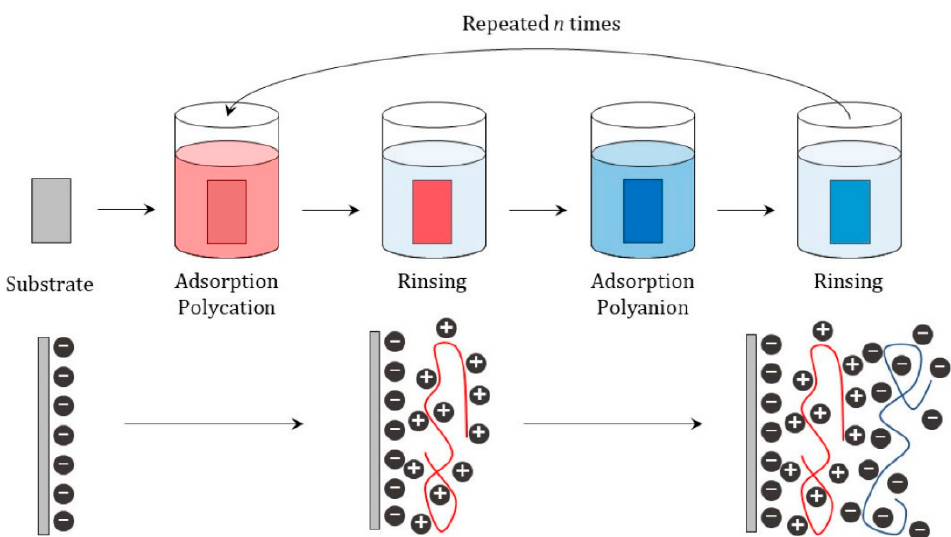
Figure 2. Sketch of the assembly of LbL nanomaterials by a dip-coating deposition methodology. The sketch represents the particular case of the assembly of a multilayer by the assembly of poly- electrolytes bearing opposite charges using a negatively charged flat substrate as template, and intermediate rinsing steps. In the bottom panel, the red line corresponds to the polycation layer evidenced by its positive charges, and the blue line corresponds to the polyanion layer evidenced by its negative charges. Reprinted from Mateos-Maroto et al. [64], with permission under Open access CC BY 4.0 license, https://creativecommons.org/licenses/by/4.0/ (accessed on 7 April 2022).